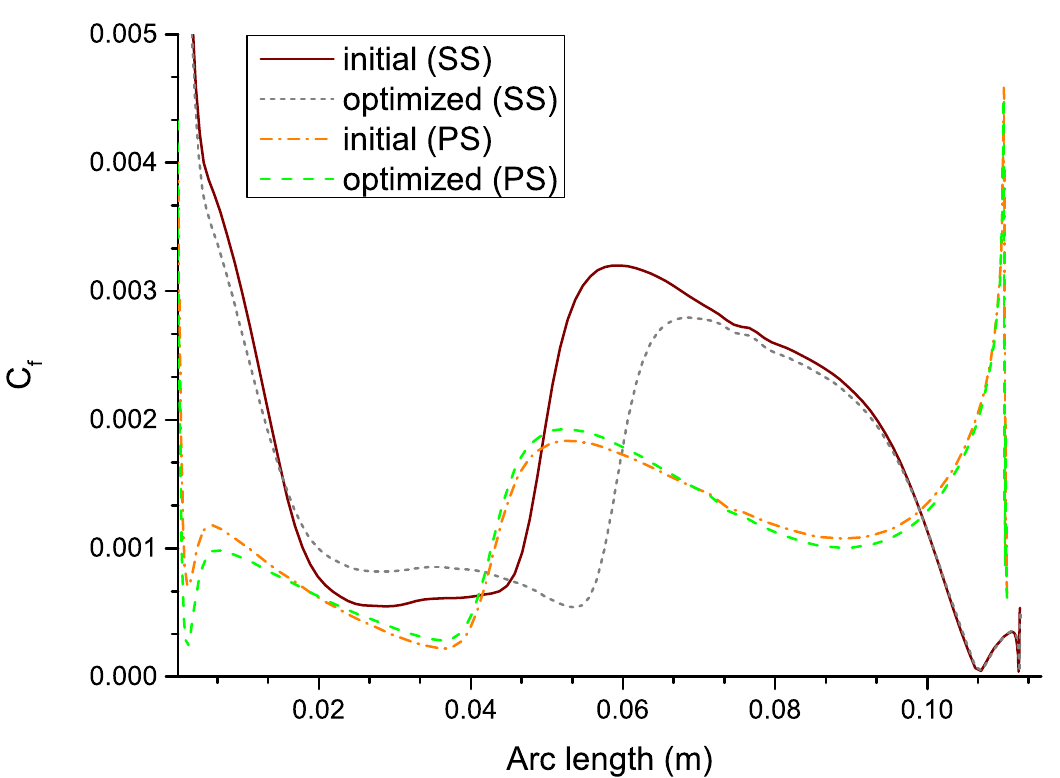
Figure 18. C f distributions on suction and pressure surfaces. The absolute Mach number contours of the original and the optimized blades are plotted in Figure 19. Compared with the initial profile, the shock wave at the suction surface is weakened and moved aft. This results in a reduction in shock loss, which is also a contribution to the decrease of the total pressure loss.